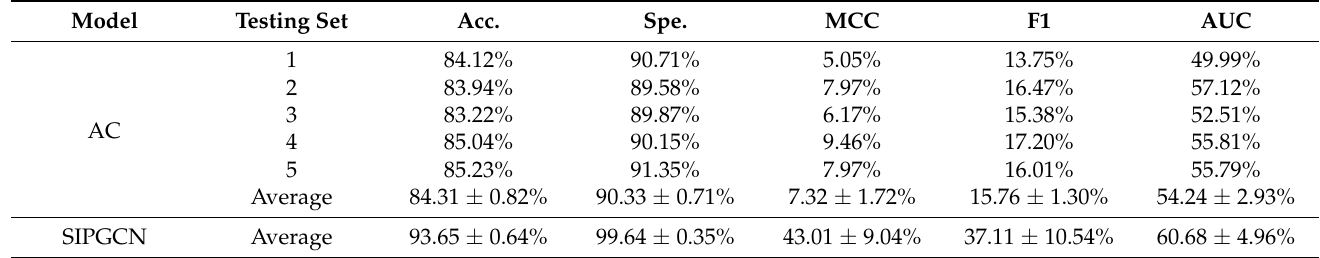
Table 5. Comparison of SIPGCN with an AC feature model in the human data